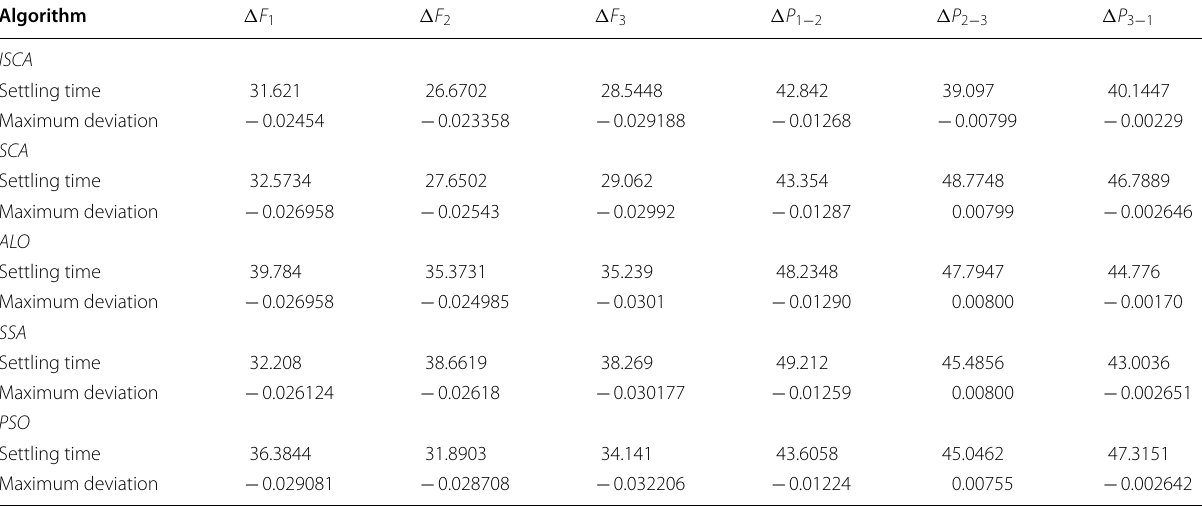
Table 8 Performance parameters of LFC with ISCA, SCA, ALO, SSA, and PSO for the three-area system with physical constraints with SLD of 1% in area-1